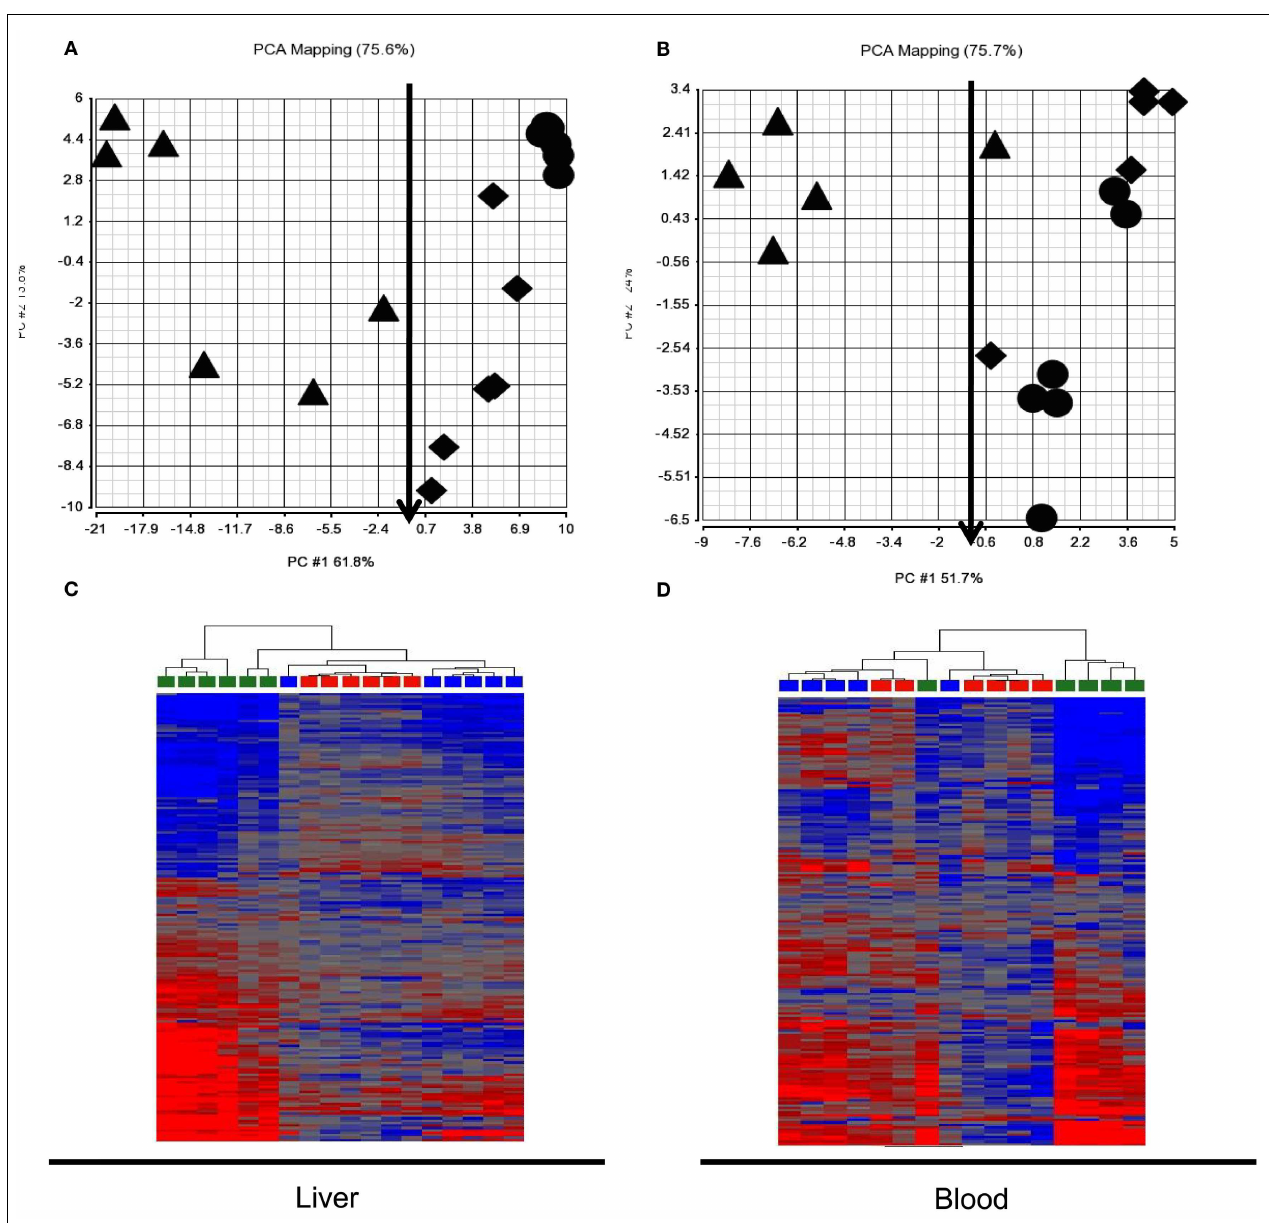
red in (A,B) ] and toxic dose [diamond and triangle in (A,B) , blue and green in (C,D) ] in both liver (A,B) and blood (A,B) . (A) Liver PCA result; (B) Blood PCA result; (C) . Liver HCA result; (D) . Blood HCA result. For HCA, samples were grouped by Euclidean distance and average linkage. Legends for (A,B) : circle, subtoxic dose; diamond, toxic dose without liver injury;Triangle, toxic dose with liver injury. Legends for (A,B) : red, subtoxic dose; Blue, toxic dose without liver injury; Green, toxic dose with liver